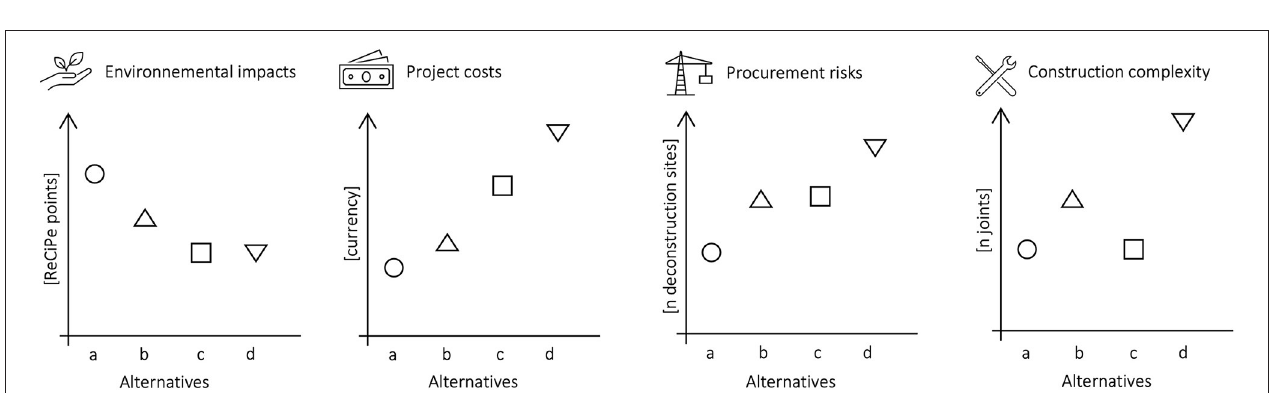
FIGURE 4 | Evaluation of design alternatives for each criterion: Illustrative example of four design alternatives ordered from left by increasing reuse